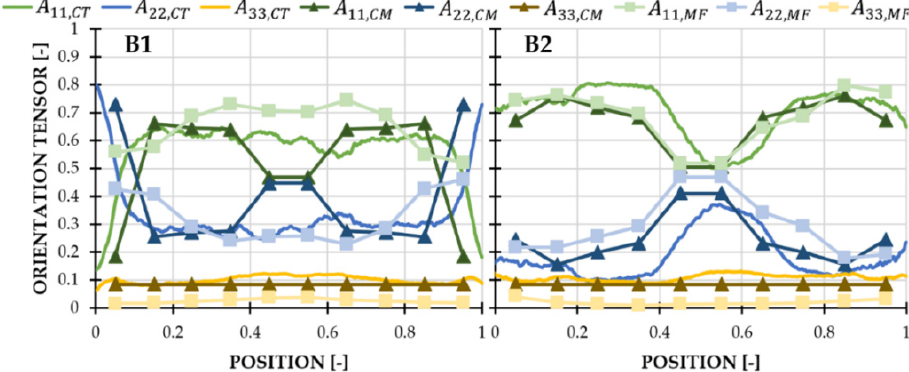
Figure 8. Experimental (CT) and simulative (CM, MF) components of the fiber orientation tensor A ij plotted over normalized position for PA66GF50 at component level (B1–B2). Table 2. Relative deviation of the averaged orientation tensors from experiment 𝐴 (cid:3036)(cid:3037),(cid:3004)(cid:3021) and simula- tion 𝐴 (cid:3036)(cid:3037),(cid:3004)(cid:3014) , 𝐴 (cid:3036)(cid:3037),(cid:3014)(cid:3007) of PA66GF50 on component level (B1–B2).